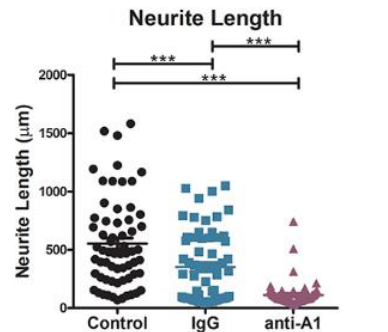
Figure 4. Anti-A1 antibodies damage neurites. Anti-A1 antibodies or IgG isotype control antibodies were added to primary neurons. IgG and anti-A1 antibodies both led to decreased neurite length; however, anti-A1 antibodies augmented neurite damage and led to significantly decreased neurite length as compared to both control and IgG-treated neurons. One-way ANOVA with Tukey’s post hoc tests with *** p < 0.001. Each dot represents an individual neuron with error bars +/− SEM. Scale bar 20 μm.